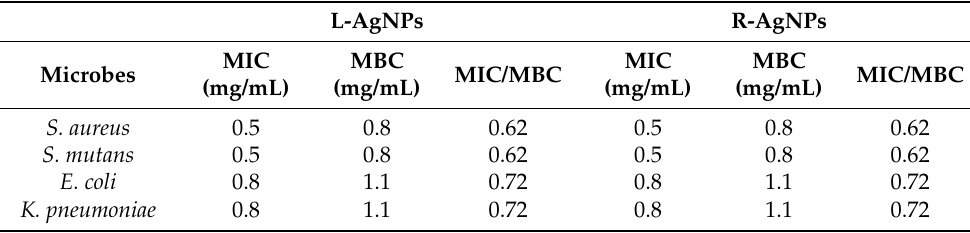
Table 2. Minimum Inhibitory Concentration (MIC) and Minimum Bactericidal Concentration (MBC) of L-AgNPs and R-AgNPs against the tested